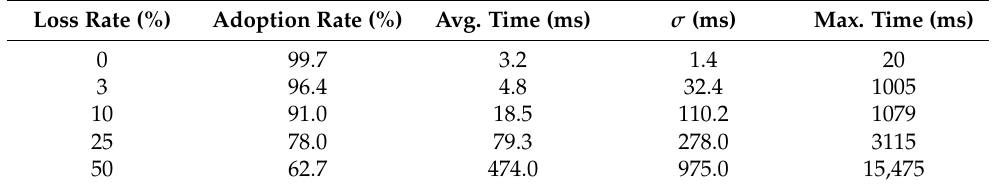
Table 3. HTTP/3 adoption rate and connection establishment time with packet loss settings. (Happy Eyeballs).